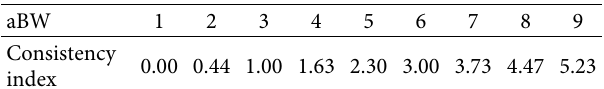
Table 1: Consistency index.